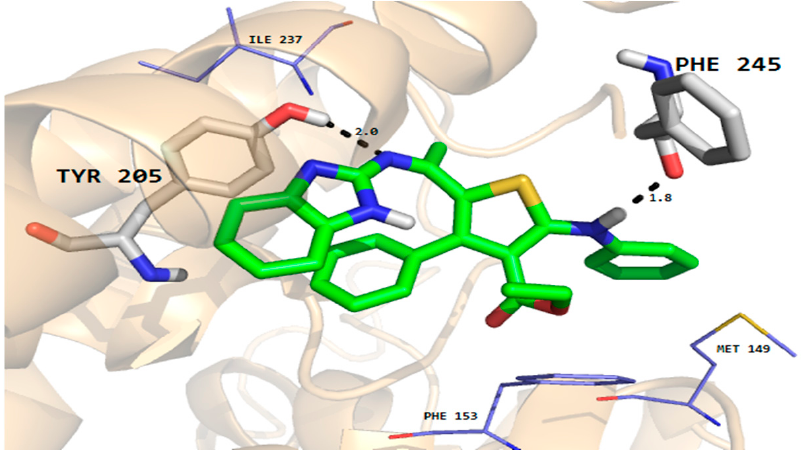
Figure 7. Molecular docking conformation of compound 7 in the active site of C. albicans dihydrofolate reductase protein (PDB ID 4HOF) showing hydrogen bonding, hydrophobic and van der Waals interactions.